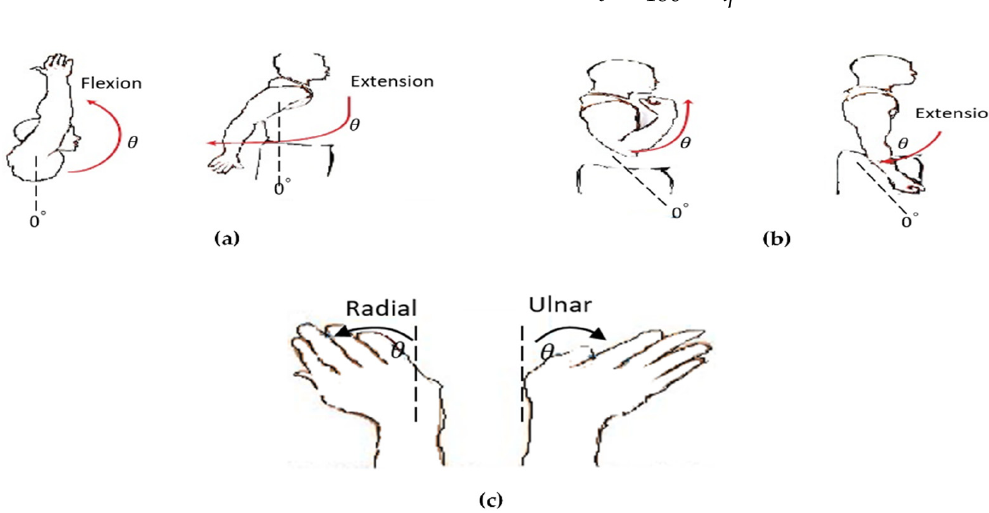
Figure 4. Flexion and extension of the ( a ) shoulder joint and ( b ) elbow joint, and ( c ) radial-ulnar deviation of the wrist joint. Source: Clark et al. (2010).